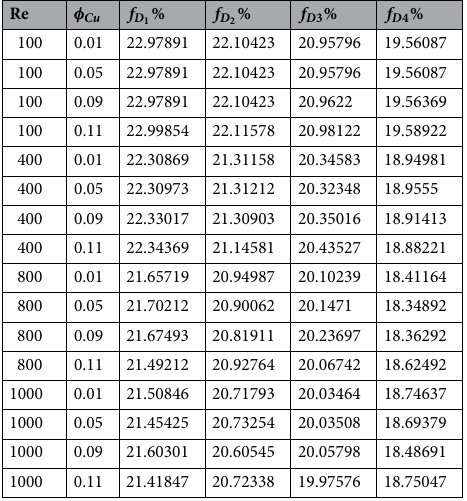
Table 5. Percentage change in the friction force when the aspect ratio of the cavity is changed to the next % = The percentage when the aspect ratio is turned from 1 to 1.5. f D parameter. Where f D 1 % = The percentage when the aspect ratio is turned from 2 to when the aspect ratio is turned from 1.5 to 2. f D 3 % = The percentage when the aspect ratio is turned from 2.5 to 2.5. f D 4